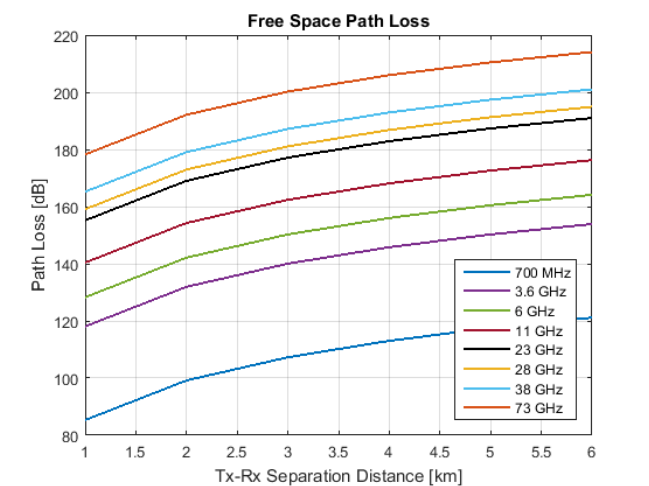
Fig 20. Free space path loss at Tx-Rx separation distance of 6 km